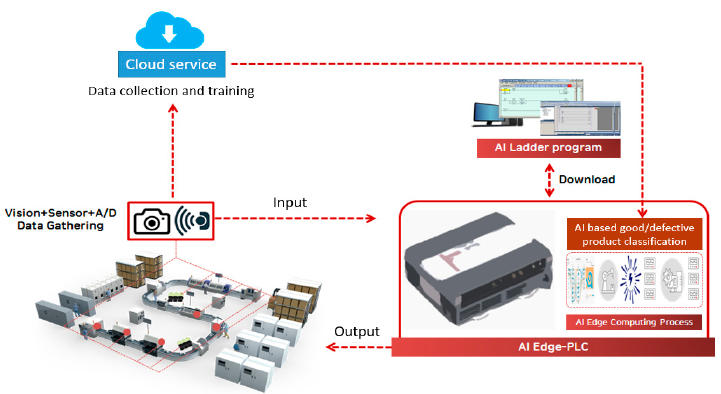
Figure 2. Architecture of the smart factory.